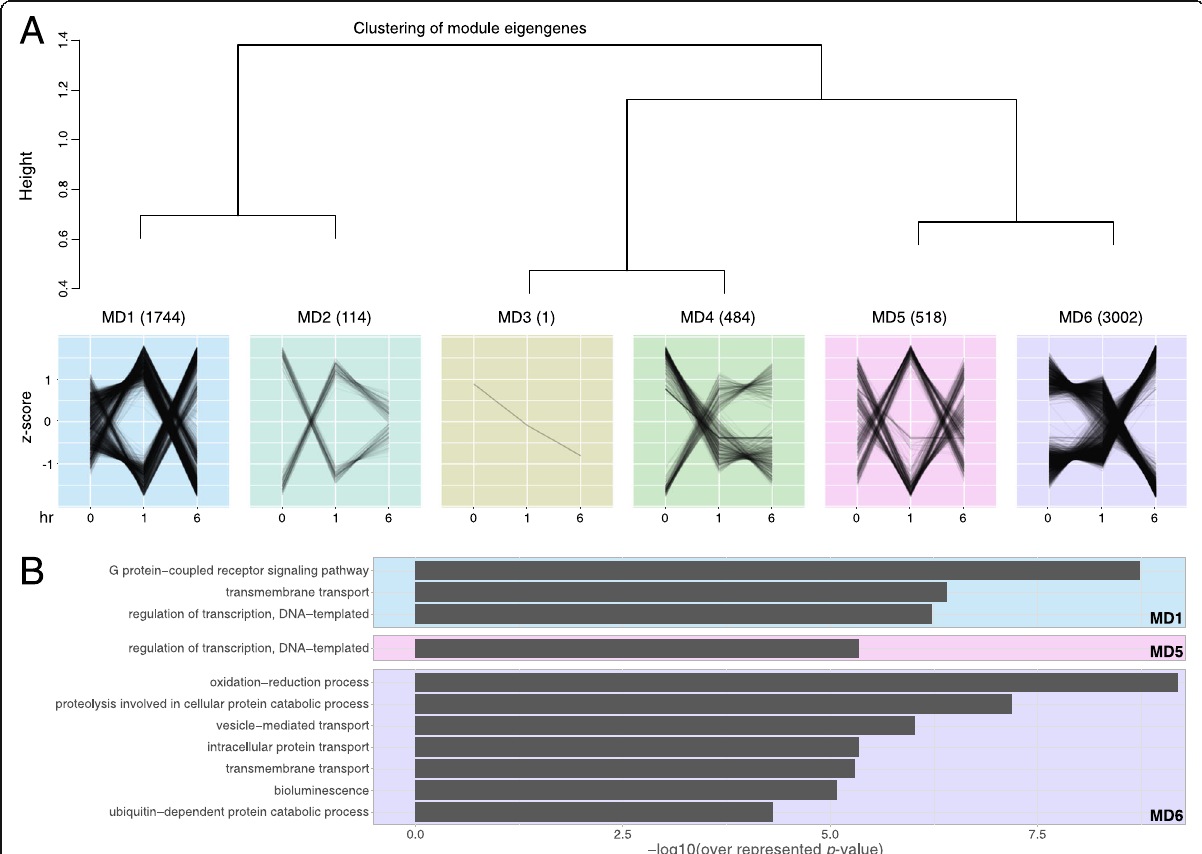
Fig. 4 Modular analysis of the expression patterns of the DEGs by WGCNA in the three-group comparison. A The dendrogram of the modules and the expression pattern of the genes in each module. The number in parentheses indicates the number of genes clustered into each module. The average values of the z scores of gene expression levels over time are shown by a line plot. B GO enrichment analysis for each module. Only BP categories are shown. MD2, 3, and 4 have no enriched terms